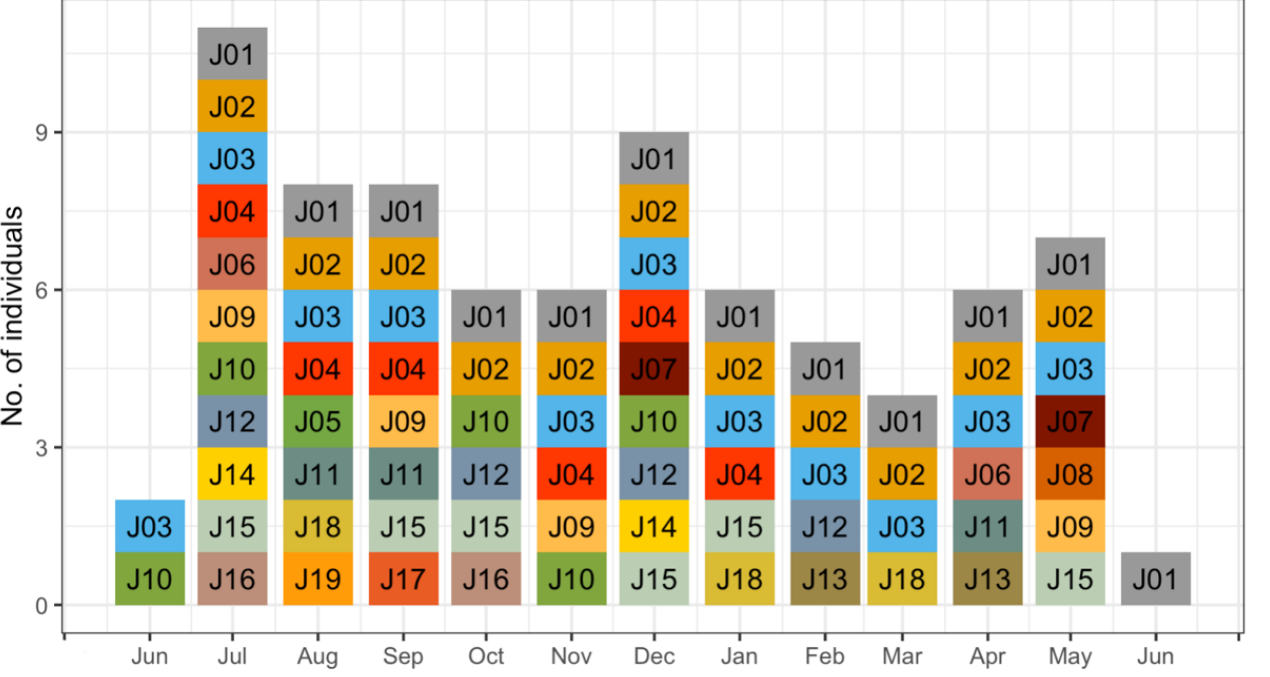
Figure 3. Monthly number of jaguar individuals (number- and color-coded) registered (June 2016– June 2017) in a camera trap density study in Sector Santa Rosa, Guanacaste Conservation Area, Northwestern Costa Rica .